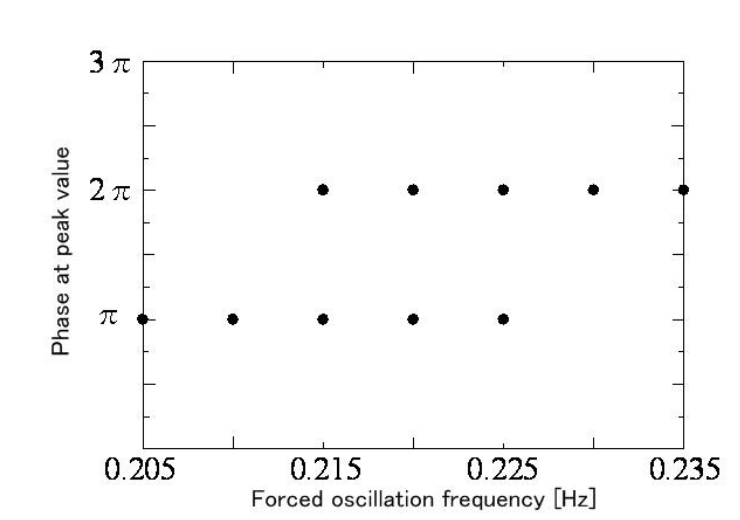
Fig.4 Peak phase in probability density Distributions for each forced oscillation frequency